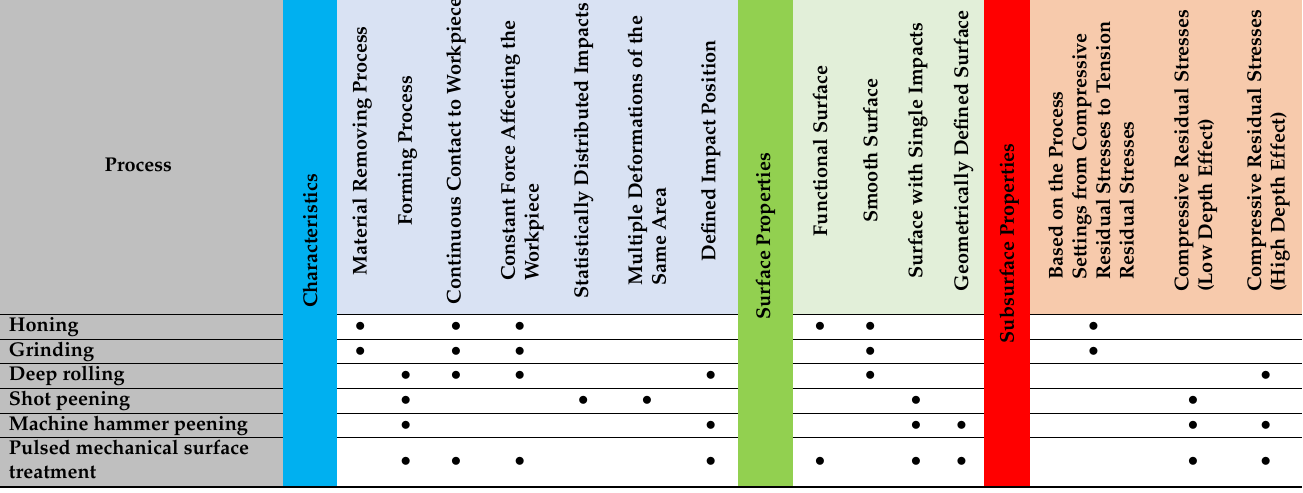
Table 1. Common finishing processes and their influence on surface and subsurface properties (cf. e.g., [1,4,17].).